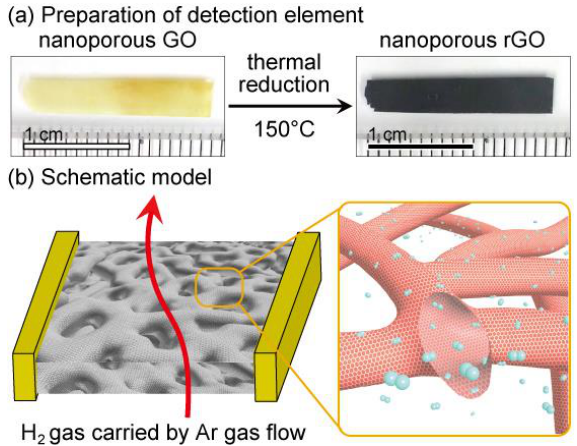
Figure 1. Nanoporous reduced graphene oxide. ( a ) Optical images of nanoporous graphene oxide (GO) and nanoporous reduced GO (rGO), and ( b ) a schematic illustration of the detection element of nanoporous rGO with details. The inset shows the tubular graphene ligaments.